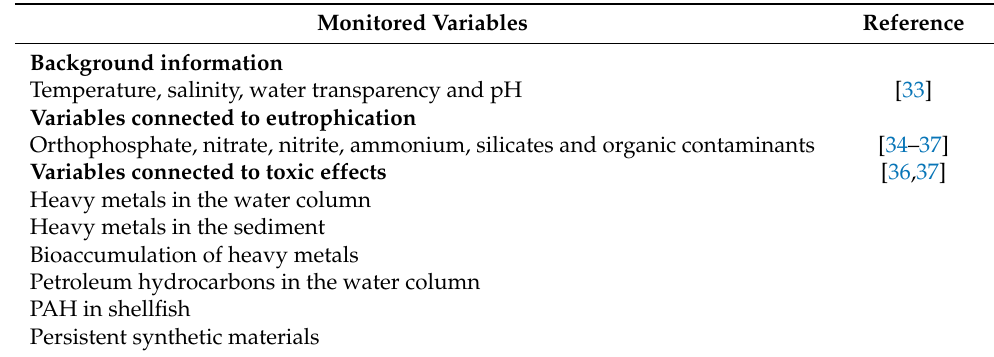
Table 1. Some examples of variables monitored in marine water quality studies according to the requirements of international conventions and